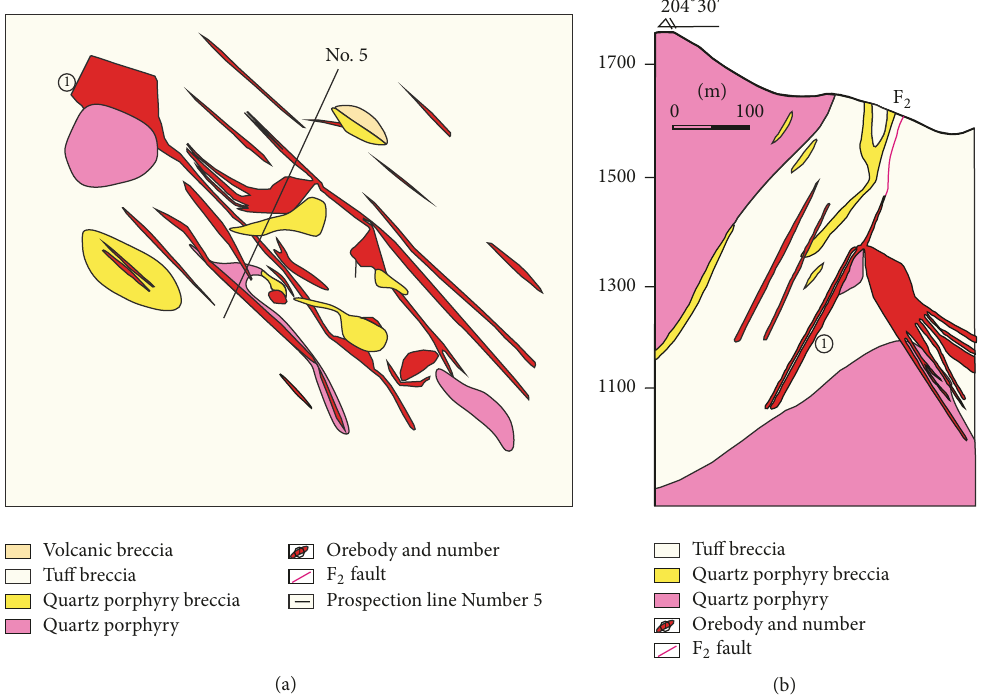
Figure 3: (a) Simplified level plan 1320 (modified from [13]); (b) geological cross section of number 5 exploration of the Zhijiadi deposit (modified from